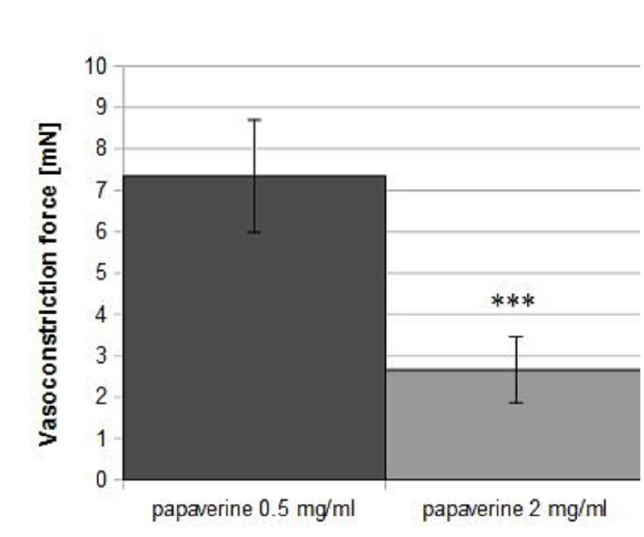
Fig. 2 – Potassium chloride (KCl) and phenylephrine induced contraction of radial artery segments predilated by papaverine 0.5 mg/ml (n=12) and 2 mg/ml (n=12).